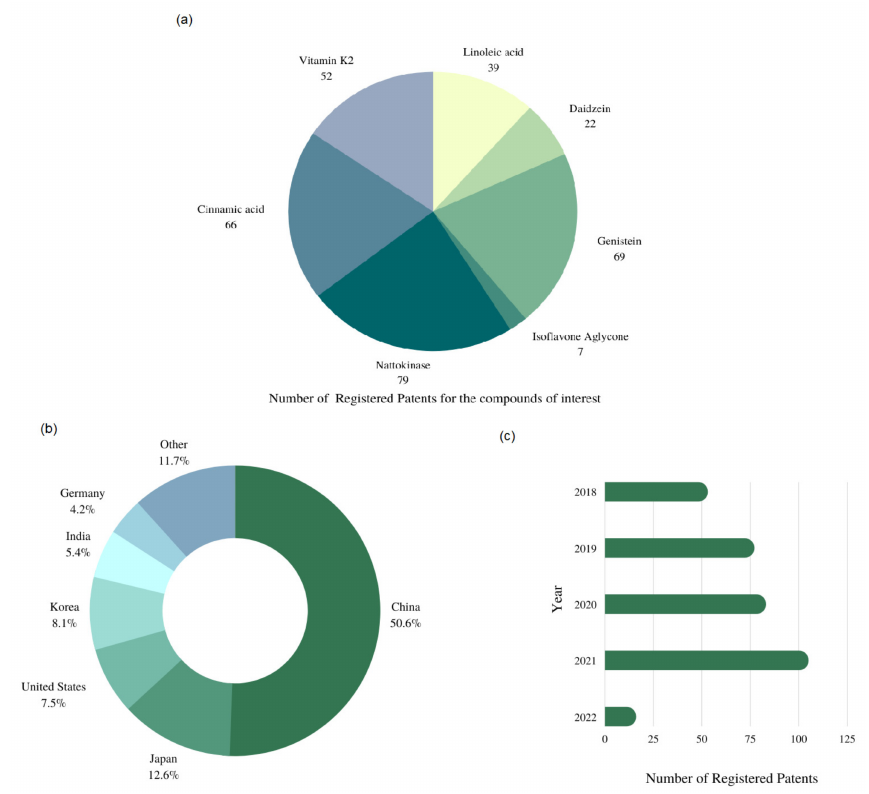
Figure 4. Number of registered patents for the compounds of interest ( a ), countries ( b ), and years ( c ) of